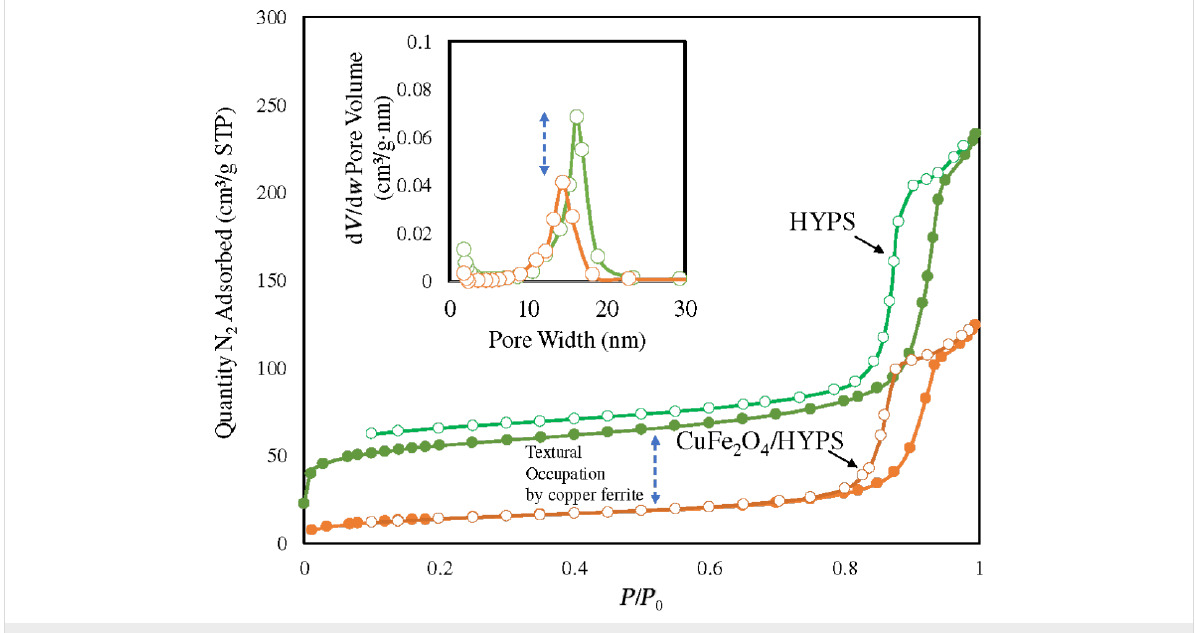
Figure 2: BET adsorption–desorption isotherm and pore size distribution of (a) HYPS and (b) 30 wt% CuFe 2 O 4 /HYPS.